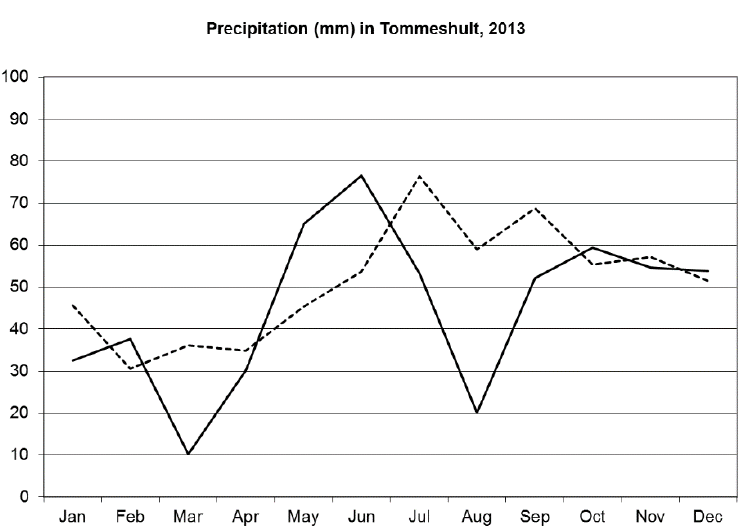
Figure 3. Monthly precipitation in mm at the Swedish Meteorological and Hydrological Institute (SMHI) weather stations over the study period ( ____ ). The 30-year average values for the same period (1961–1990; -----) are also shown.